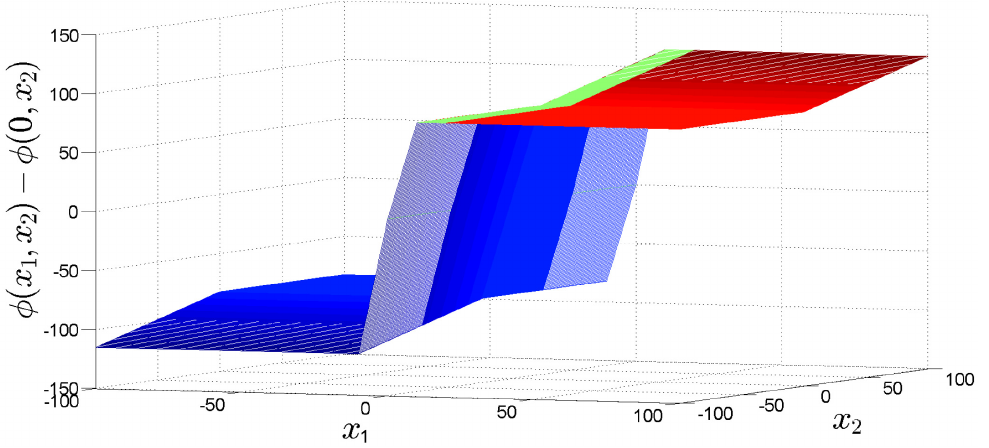
Figure 7. 3D representation of φ ( x 1 , x 2 ) – φ ( 0, x 2 )